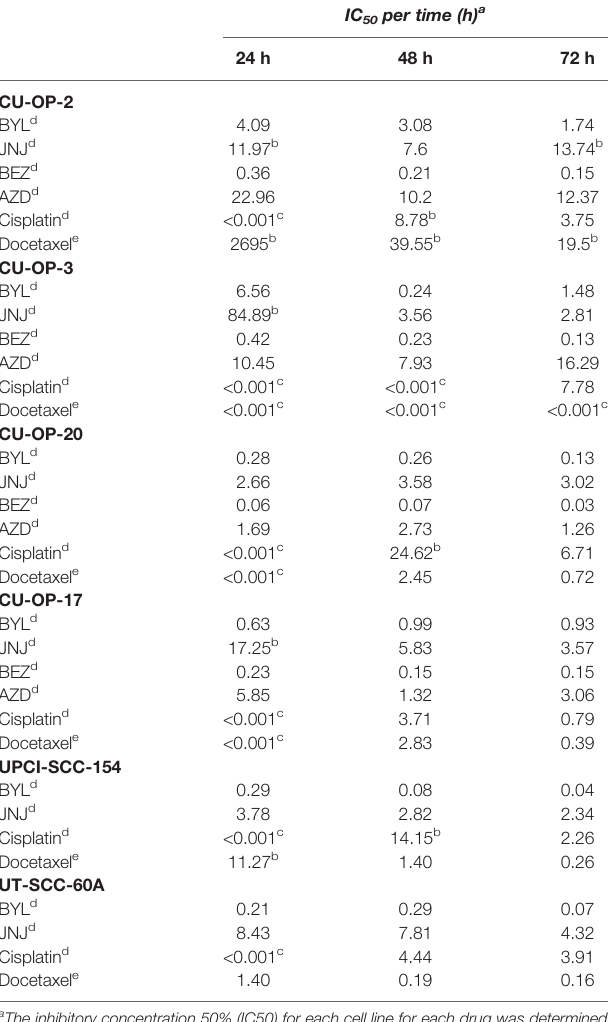
TABLE 1 | Estimation of inhibitory concentration 50% (IC 50 ) based on WST – 1 viability analysis following treatment with the FGFR inhibitor (JNJ-42756493 and AZD4547), PI3K inhibitors (BYL719 and BEZ235), and the chemotherapeutic drugs cisplatin and docetaxel for 24, 48 and 72